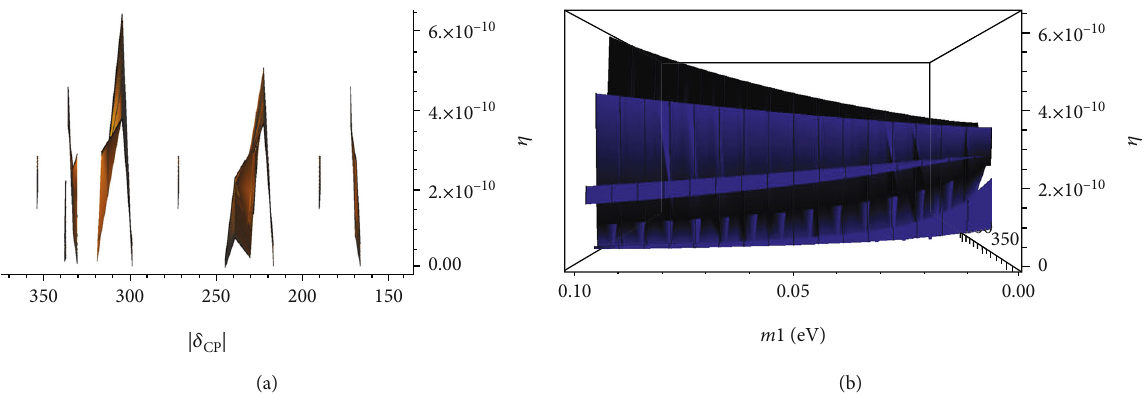
Figure 3: Predictions in the broken μ − τ symmetry model for normal ordering: (a) the preferred values of δ θ = 8 : 41 of Δχ 2 = 9 : 5 w/o SK-ATM [14] (in the light of recent ratio of the baryon to photon density bounds 5 : 8times 10 − 10 < η < 6 : 6 × 1 13 0 − 10 ) as a result of contribution of the type I seesaw mechanism to neutrino mass matrix. Similarly, (b) shows the favoured values of the , for the best fi t value of δ = 222 ° of Δχ 2 = 6 : 2 [14] (in the light of recent ratio of the baryon to photon density lightest neutrino mass, m 1 CP bounds 5 : 8 × 10 − 10 < η < 6 : 6 × 10 − 10 ).